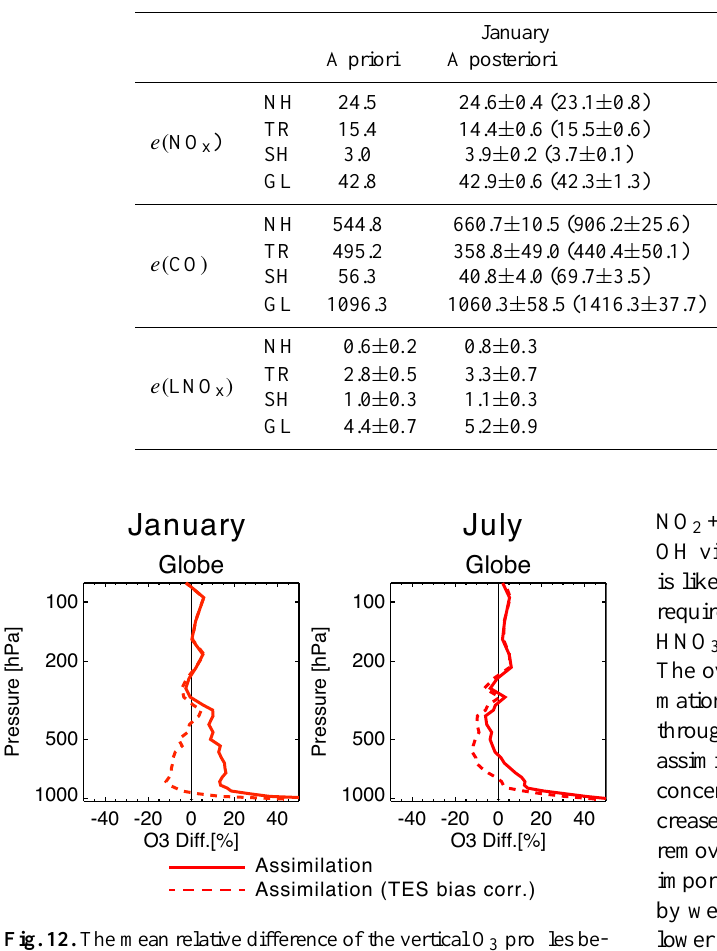
Fig. 12. The mean relative difference of the vertical O 3 profiles be- tween ozonesondes and the data assimilation with (red dashed) and without (red solid) the bias correction for TES O 3 data during 7– 30 January 2007 (left) and 7–30 July 2007